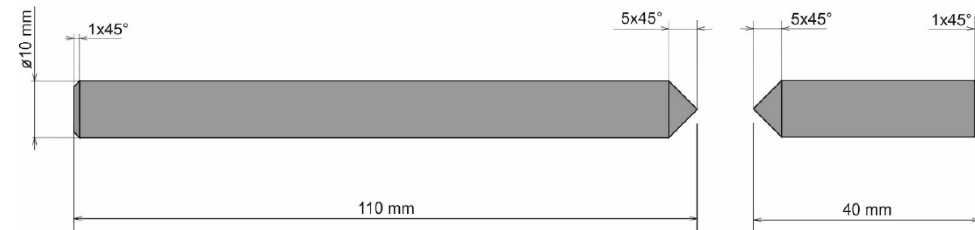
Figure 12. Gamma-geometry of the weld surface for the evaluating the fatigue characteristics.